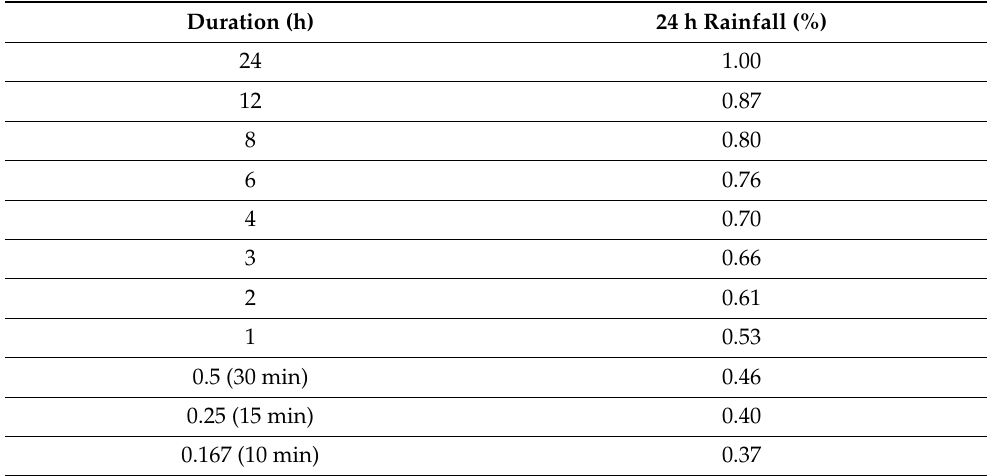
Table 7. Ratio to daily rainfall.